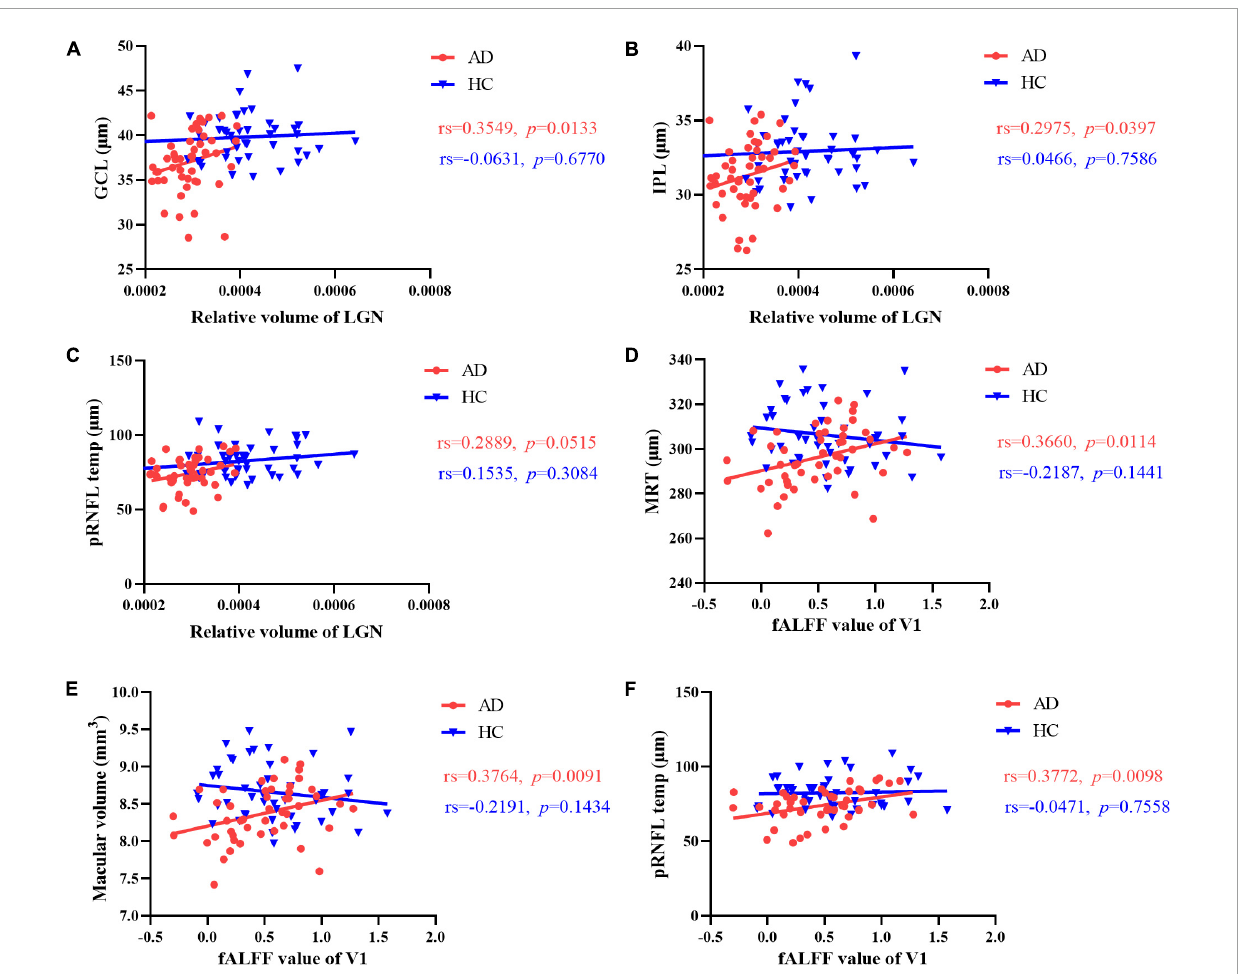
FIGURE5 Correlation between brain structure, intrinsic activity changes and retinal thickness. The relative volume of LGN was correlated with (A) GCL thickness and (B) IPL thickness in AD patients. (C) No significant correlation was observed between temporal quadrant pRNFL thickness and the volume of LGN in the two group. In AD patients, there was a significant positive correlation between the fALFF value of V1 and (D) mean retinal thickness, (E) macular volume, (F) temporal quadrant pRNFL thickness. No correlation was found between fALFF value of V1 and the retinal thickness of any layer in HCs. GCL, ganglion cell layer; IPL, inner plexiform layer; MRT, mean retinal thickness; pRNFL, peripapillary retinal nerve fiber layer; LGN, lateral geniculate nucleus; fALFF, fractional amplitude of low frequency fluctuations; V1, primary visual